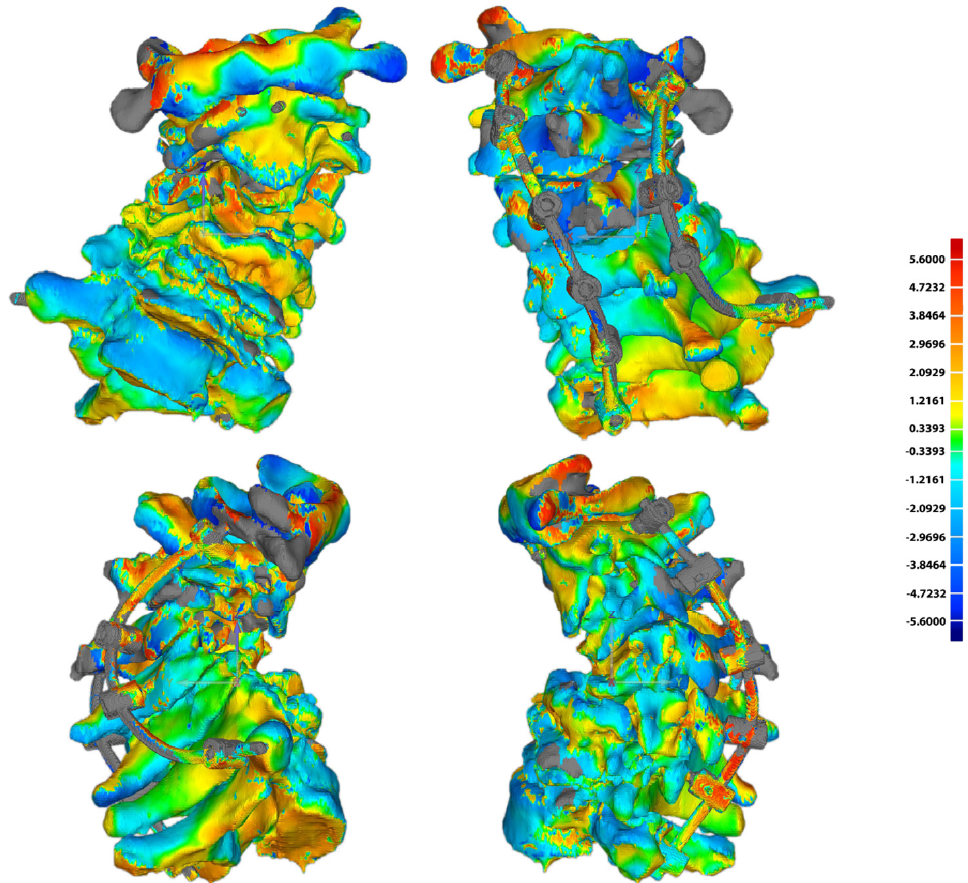
Figure 9. Software screenshots reporting the distance map analysis between PLA-VIR (target) and the POS-VIR (source); in red and blue were the areas of the model with the largest difference, in separation and interpenetration, respectively. In yellow and green were those with the smallest difference.